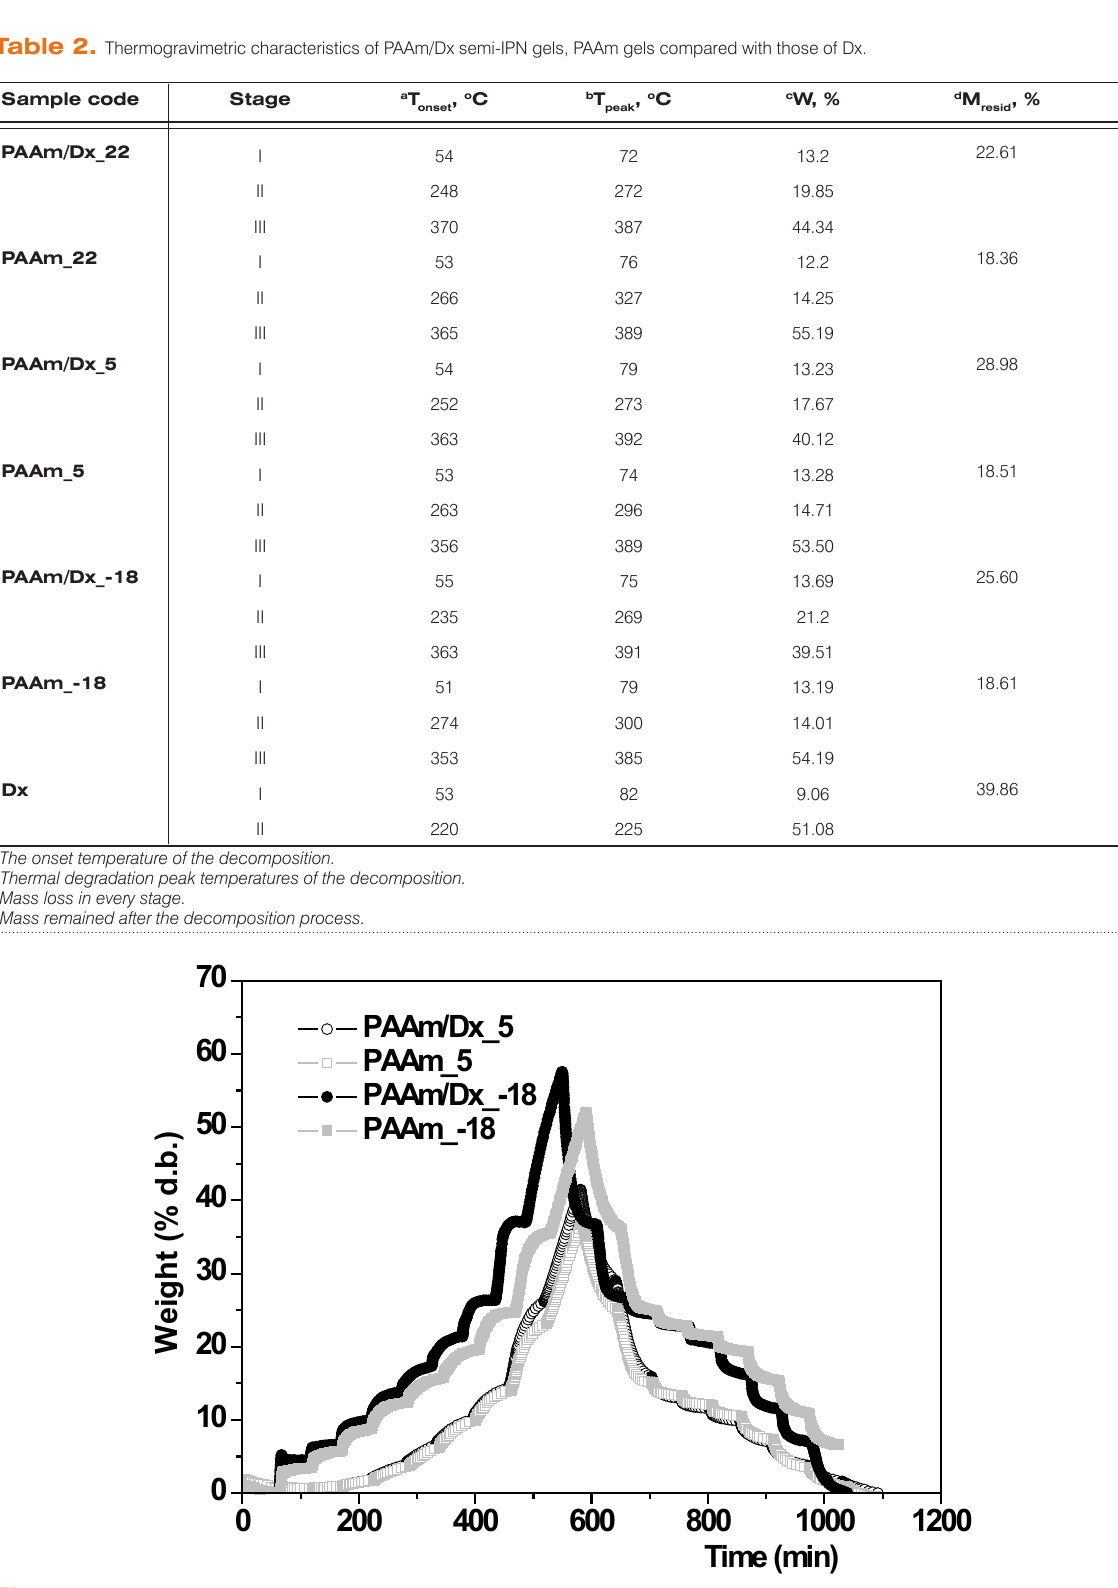
Figure 7. Water sorption-desorption kinetics of PAAm/Dx semi-IPN gels and PAAm gels prepared at 5 o C and -18 o